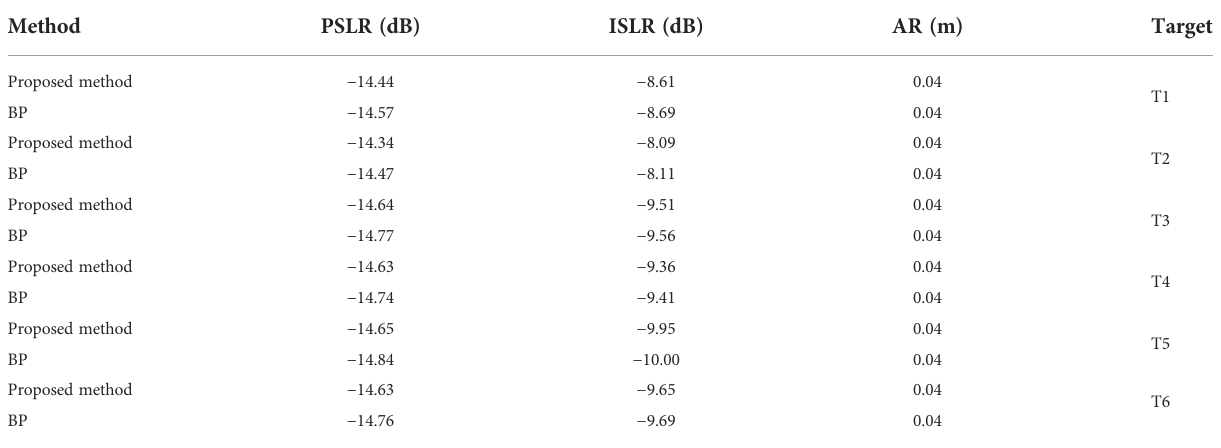
TABLE 2 Quality parameters of the focused